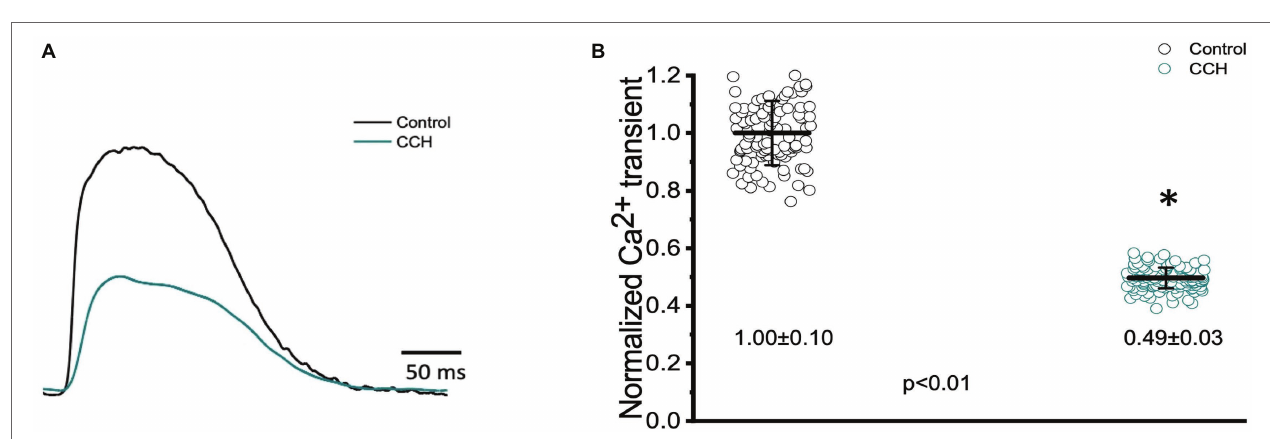
FIGURE 11 | Goldfish ventricular Ca 2+ transient recording and normalized amplitude in the absence (black) and presence (green) of 5 μ m carbamylcholine. Perfusion with carbamylcholine altered the morphology of the Ca 2+ transient (A) and significantly decreased the normalized amplitude of the Ca 2+ from 1.00 ± 0.10 to 0.49 ± 0.03 ( p < 0.01, n = 108 for the control, n = 143 for CCH, N = 8; B ). * Denotes a significant difference between the two distributions. The data are presented as multiple measurements ( n ; dot cloud) recorded for different measurements ( n ) on different hearts ( N ) with the mean ± SEM (solid